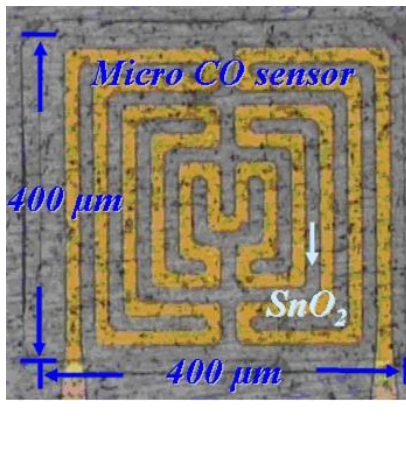
Figure 2. Optical microscopy image of a micro CO